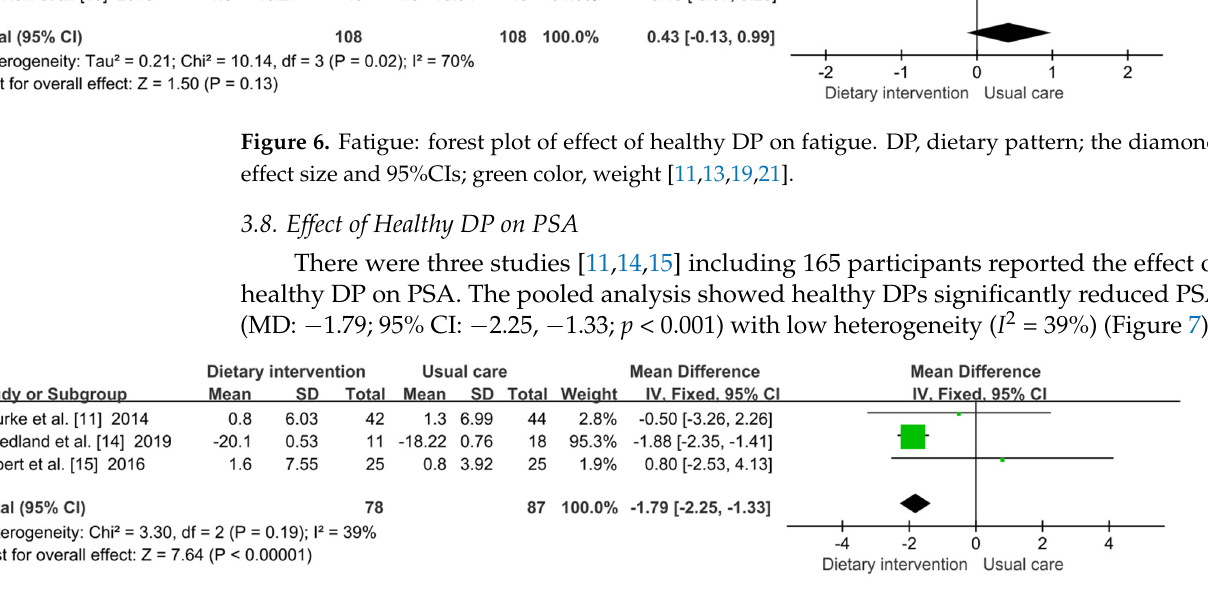
Figure 7. PSA: forest plot of effect of healthy DP on PSA. DP, dietary pattern and PSA, prostate specific antigen; the diamond, effect size and 95%CIs; green color, weight.